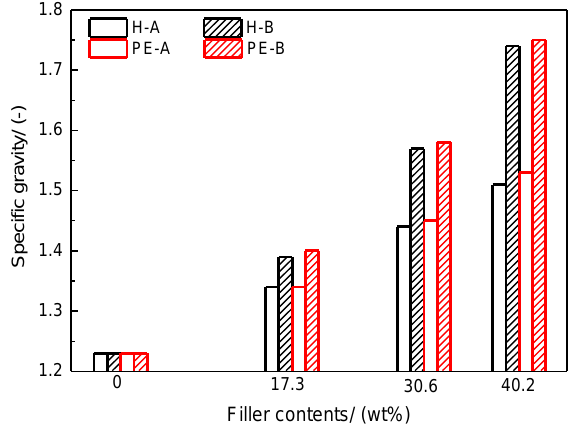
Figure 8. Specific gravities of samples.